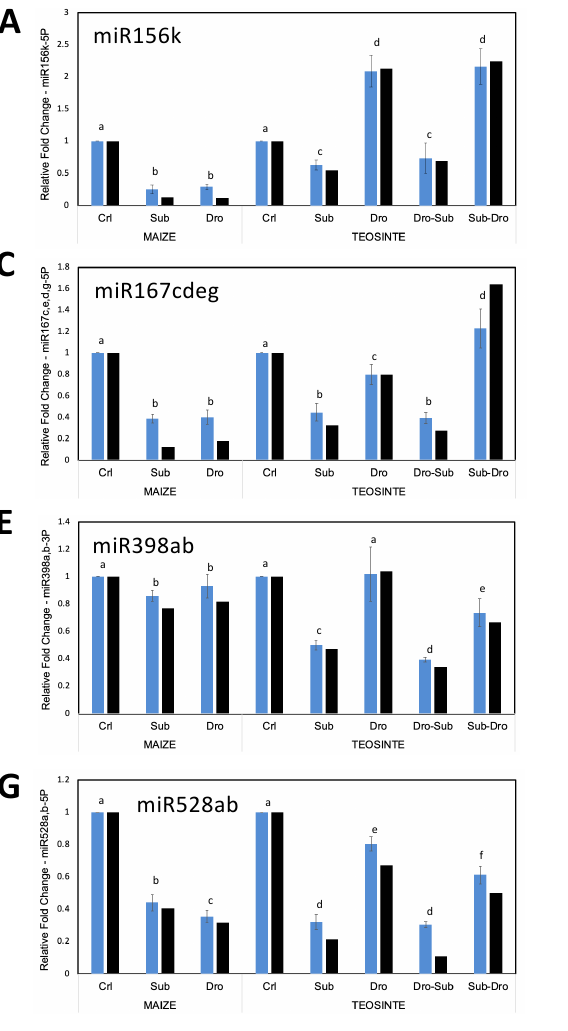
Figure 3. qRT-PCR validation of miRNAs response to submergence, drought, and alternated stress by SL-RTPCR for ( A ) miR156, ( B ) miR159, ( C ) miR167, ( D ) miR396, ( E ) miR398, ( F ) miR408, and ( G ) miR528. Relative fold change values were calculated as ∆∆ Ct for SL-RTPCR (blue bars) using miR166c as the constitutive control or as the treatment / control ratio from normalized reads for sRNA-SEQ data (black bars). Results are mean with error bars representing ± SD of three biological replicates, each replicate consisting of a pool of six plants and three technical replicates. Di ff erent letters above the error bars indicate statistically significant di ff erences between samples ( p <